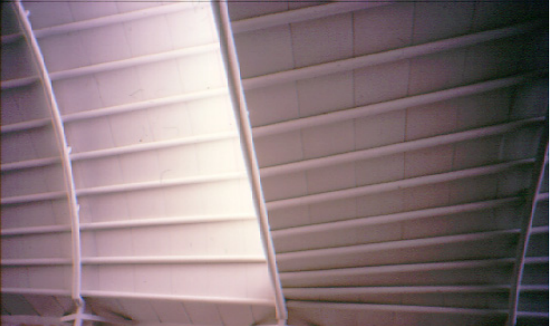
Figure 23. Interior view showing light diffusion at the central conoid. School of engineering of Seville.